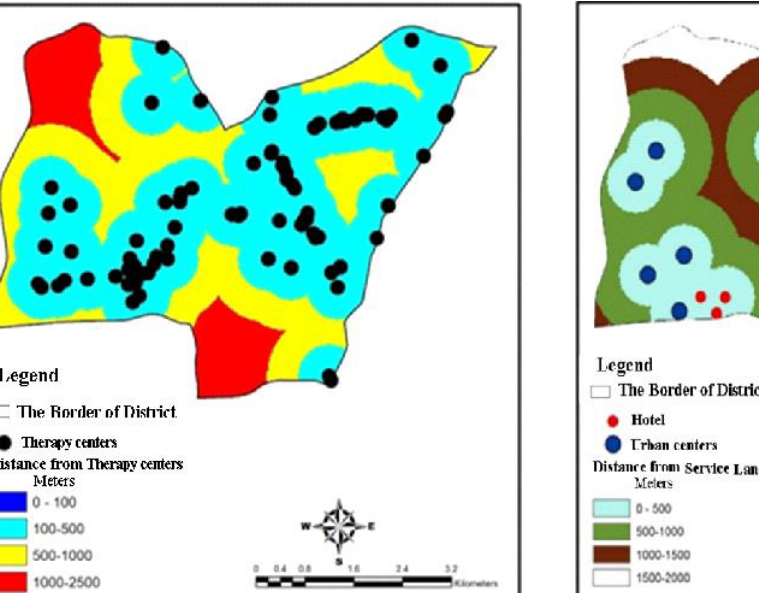
Fig. 13: The distance from Service Land